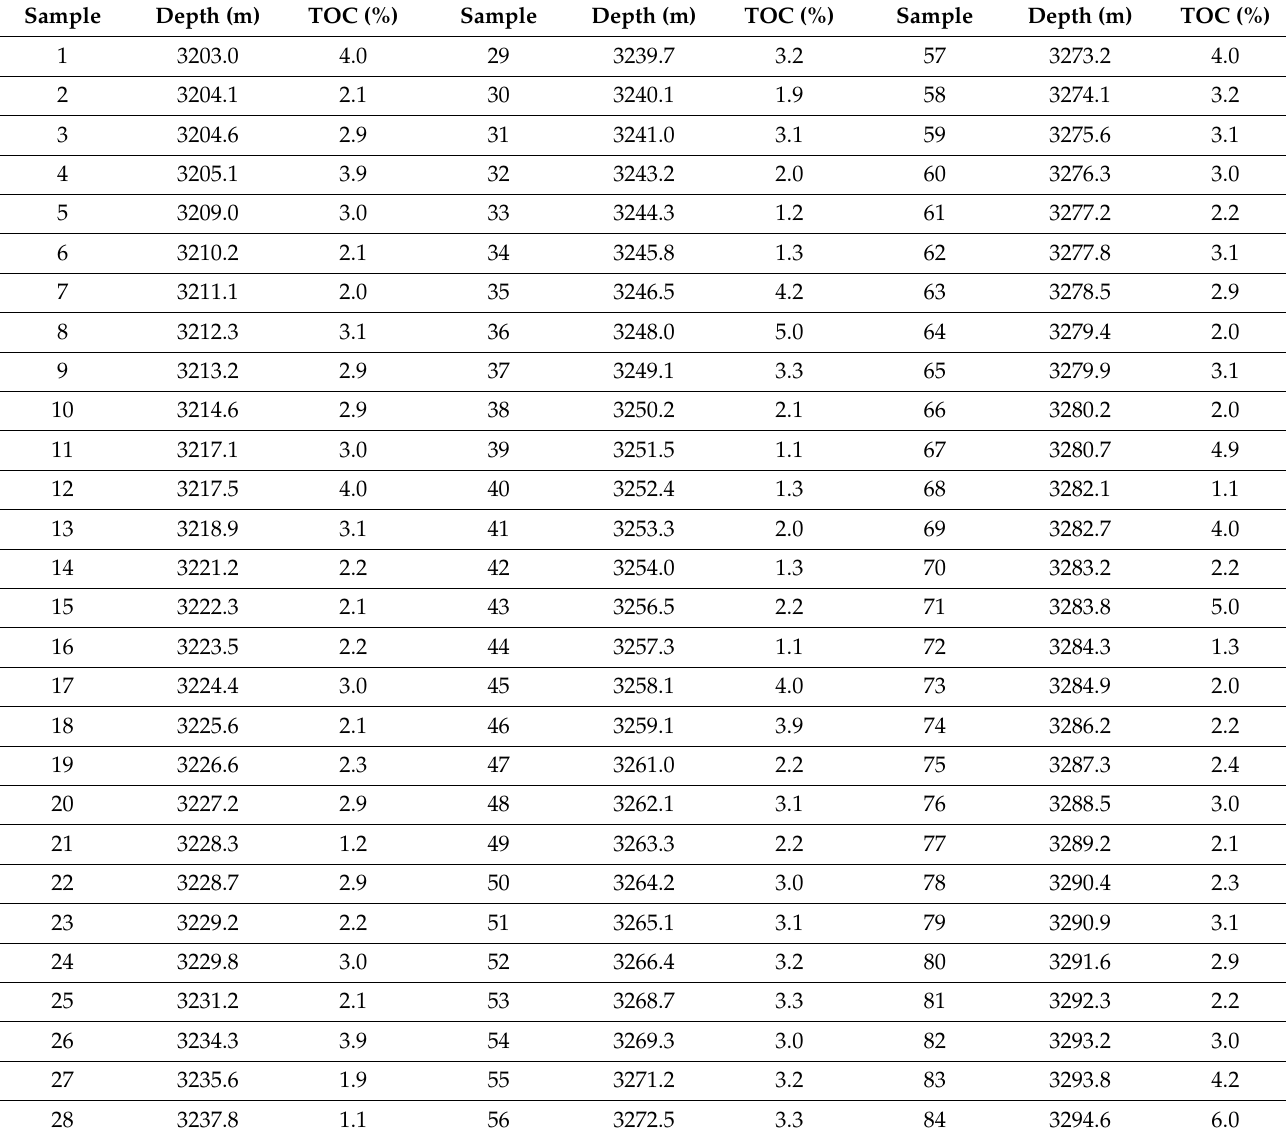
Table 2. TOC contents of shale samples from well Niu